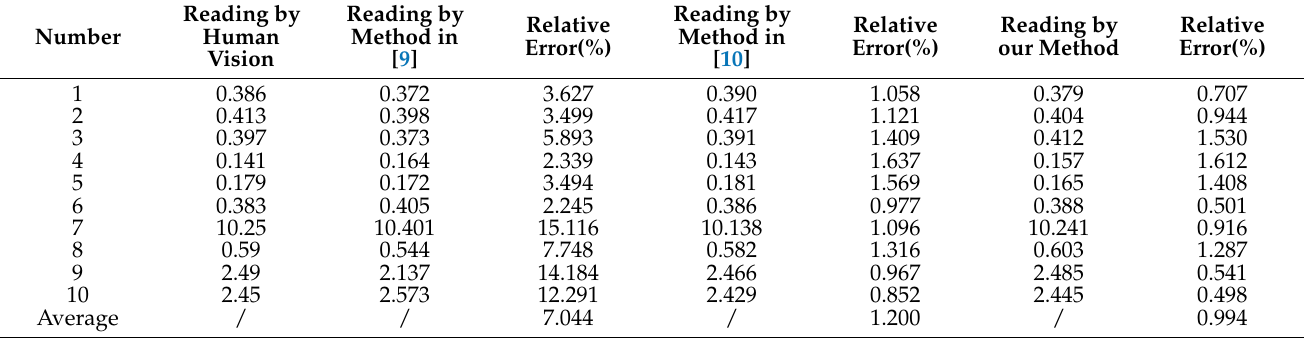
Table 5. Measurement readings of ten dial gauges using four